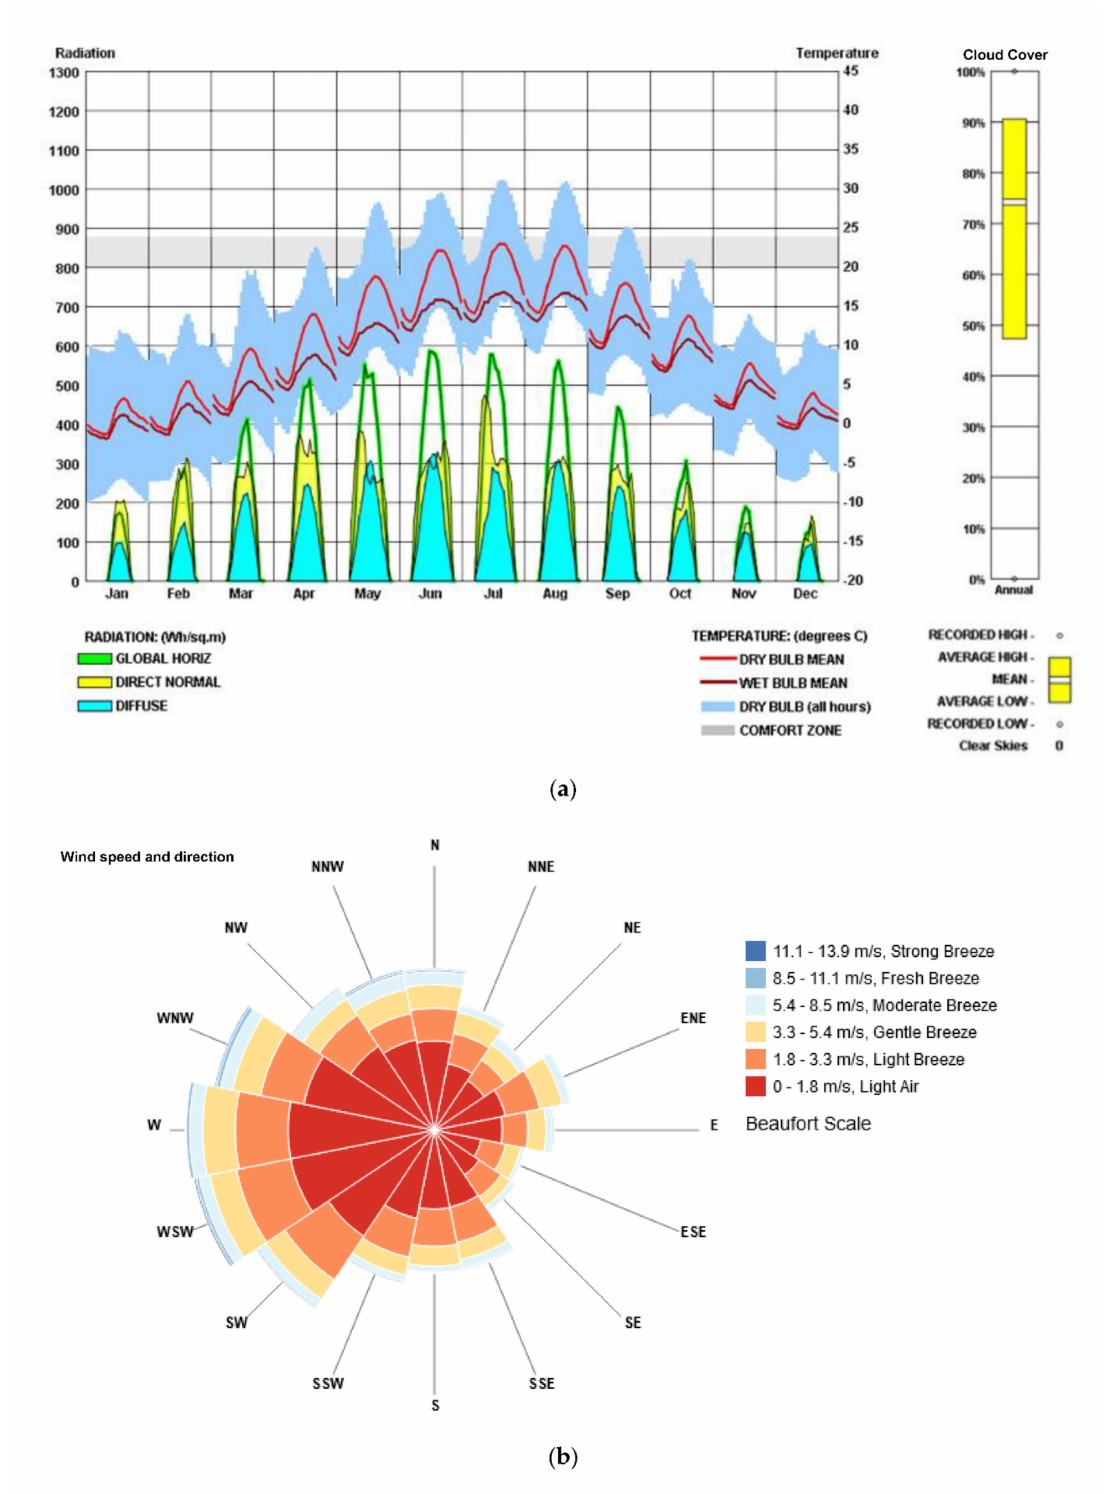
Figure 3. Climate context, extracted from the typical meteorological year ( TMY ). Monthly radiation (left axis) and temperature (right axis) in the left figure, cloud coverage in the right figure ( a ), and wind speed and direction ( b